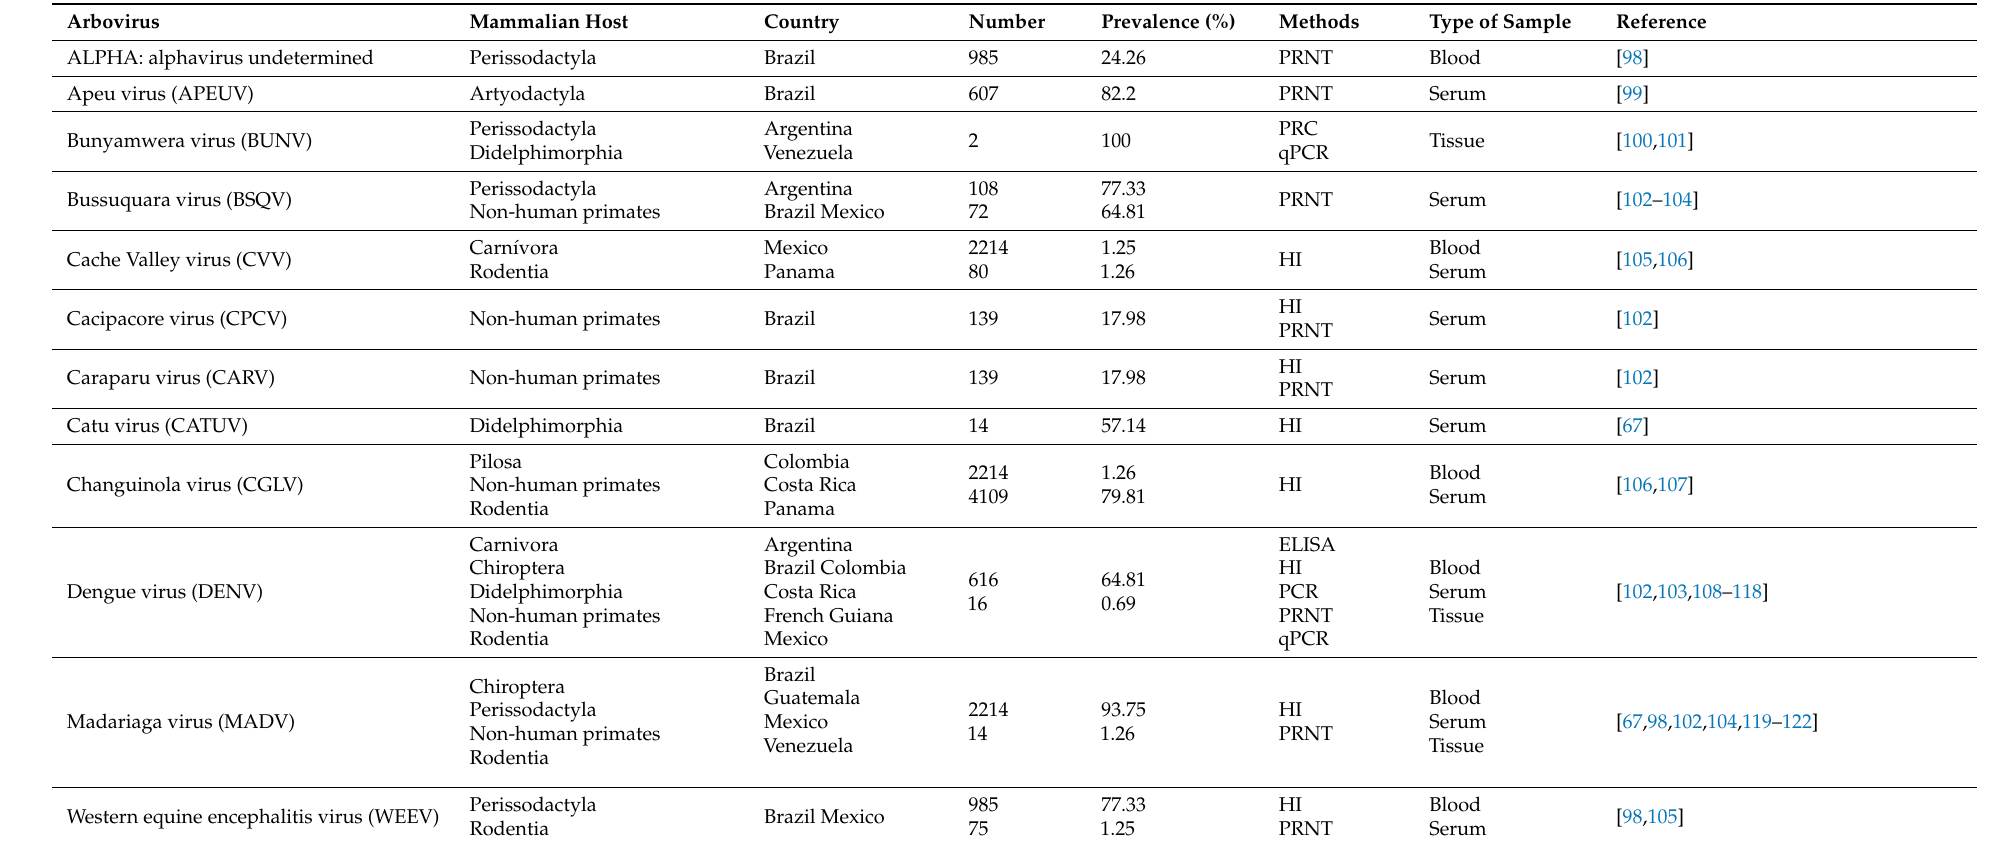
Table 1. Diversity of arboviruses in mammalian orders in the